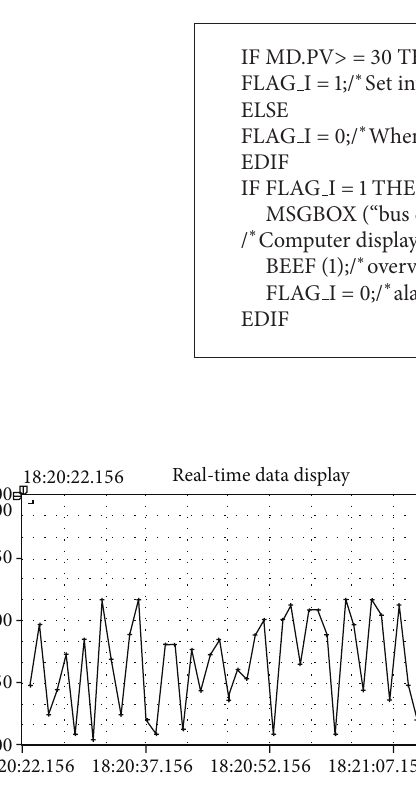
Figure 5: The interface of industrial control